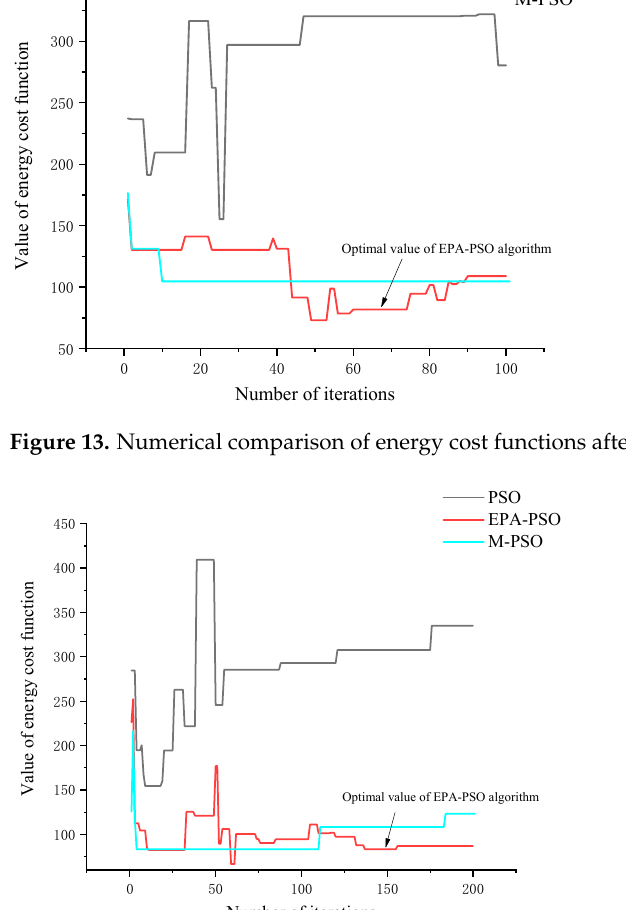
Figure 14. Numerical comparison of energy cost functions after 200 iterations.